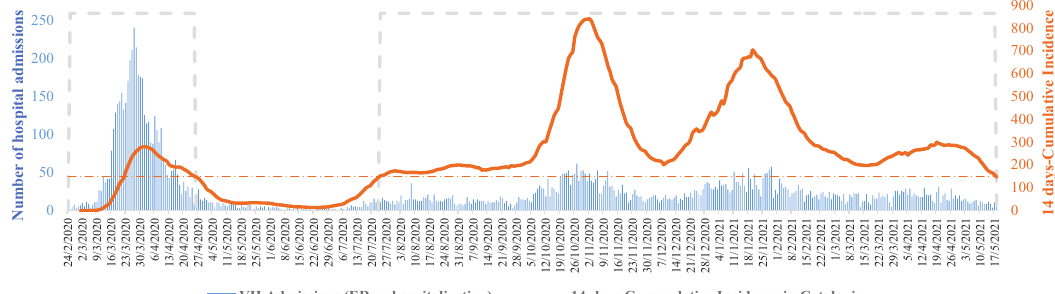
Figure1.14days-CIinCataloniaandCOVID-19hospitaladmissions(emergencyorhospitalization). Theorange dashed line shows the cumulative incidence threshold that has been defined as a very high-risk situation in Spain. The blue dashed line represents the two waves of the pandemic in Catalonia according to the criteria defined in the